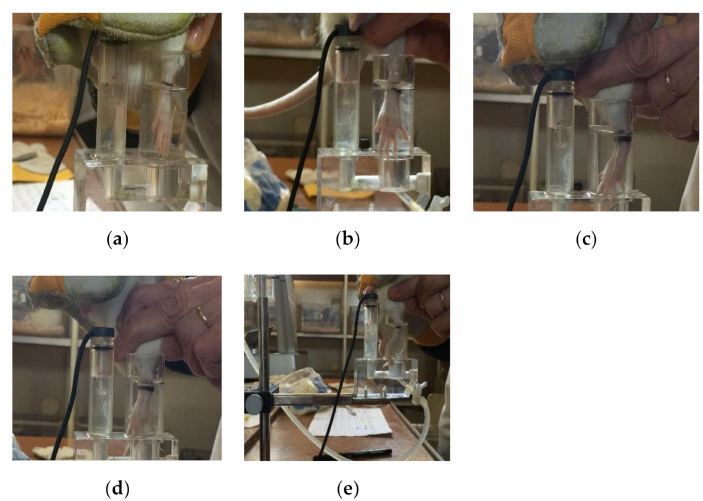
Figure 2. Images of rat paw measurement at di ff erent time intervals: ( a ) time t 0 , before carrageenan injection; ( b ) 2 h after edema induction; ( c ) 4 h after edema induction; ( d ) 6 h after induction; ( e ) 24 h after the induction of